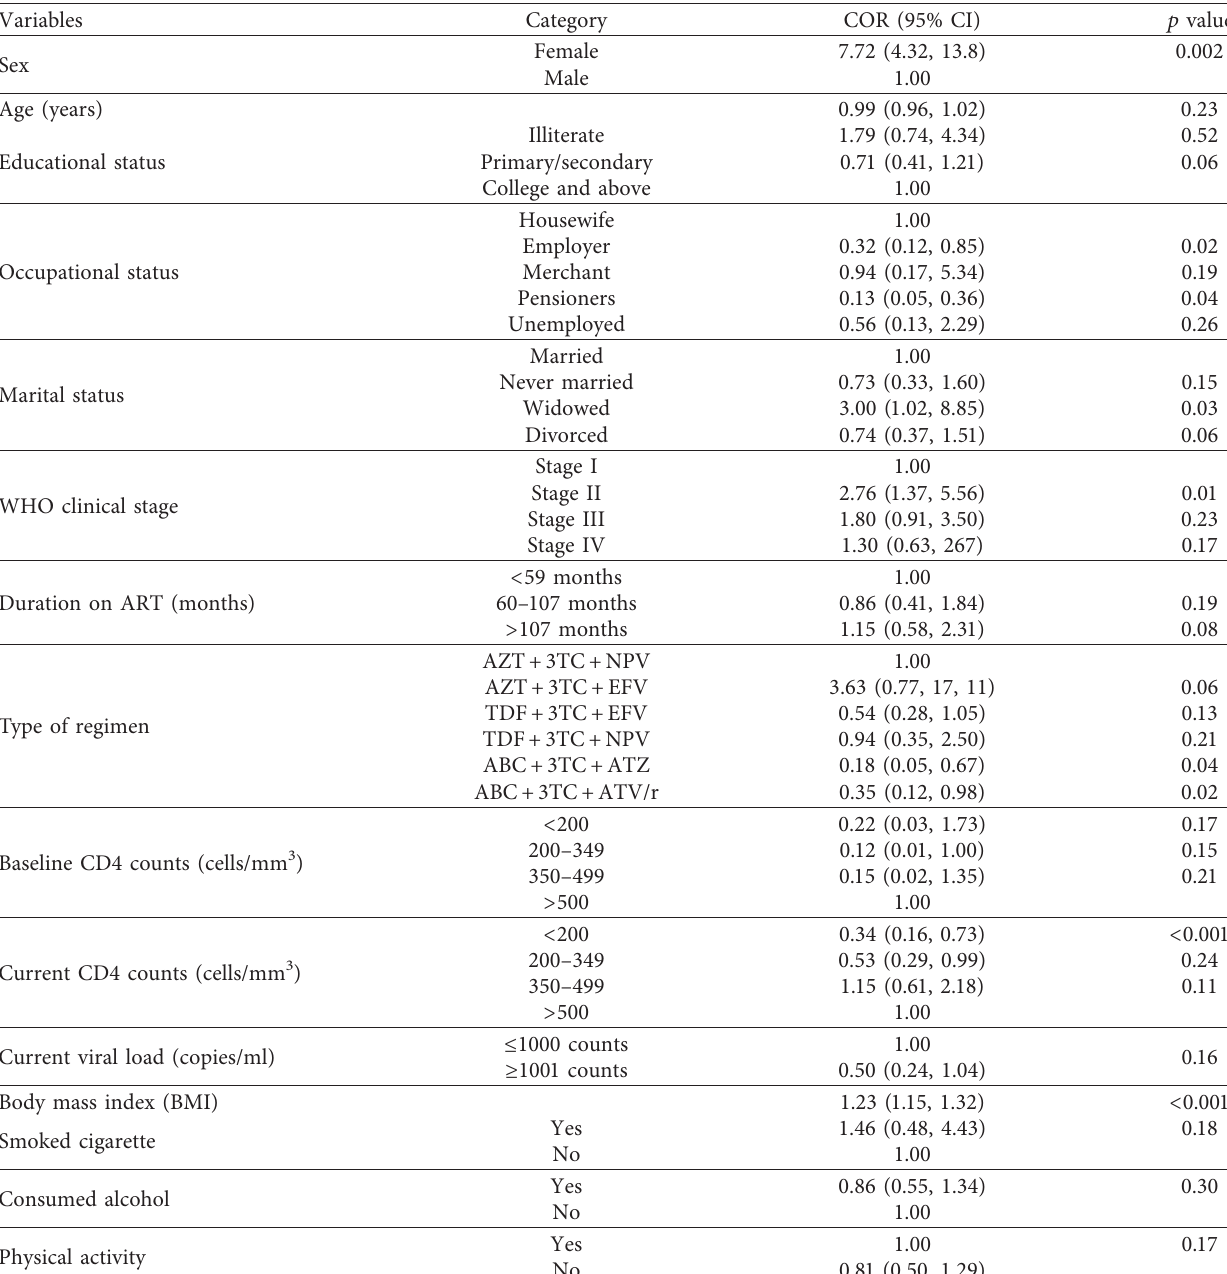
Table 5: A bivariate analysis using binary logistic regression to identify factors associated with central obesity among HIV patients who received ART at armed force comprehensive and specialized hospital, Ethiopia, 2018 ( n �